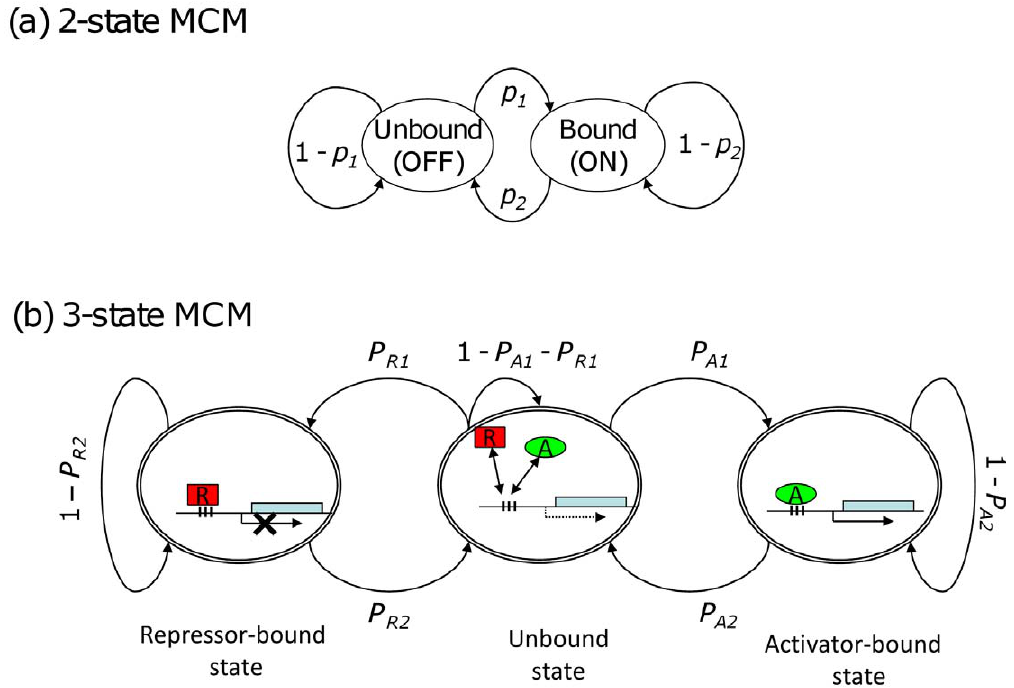
Figure 1. Transition diagrams for Markov-chain model (MCM). (a) A 2-state MCM, redrawn from the original Figure 2 in [21]. p 1 and p 2 are probabilities of transitions between a state of active transcription (ON), where TFs bind to a promoter and form a stable transcription initiation complex, and a state of no transcription (OFF). (b) 3-state MCM. To account for both activator-bound and repressor-bound states, two 2-state MCMs are combined, where unbound state (i.e., neither activator nor repressor bound) represents a state of basal-level transcription. P A1 , P A2 , P R1 and P R2 are transition probabilities between the states.